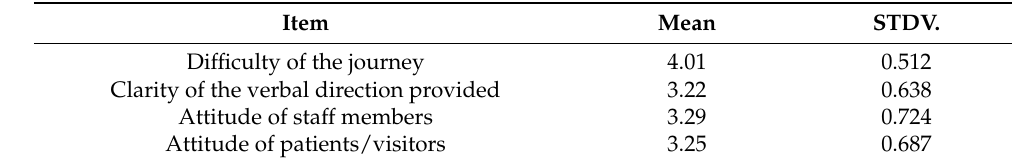
Table 3. Descriptive statistics of the responses to the human-related